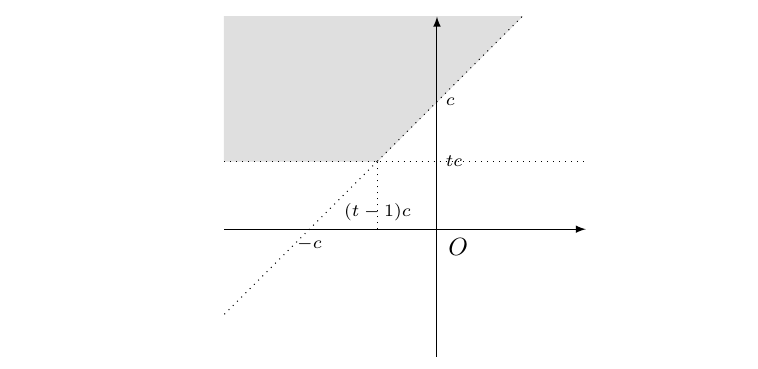
Figure 2: Region R c,t when c > 0, 0 < t <